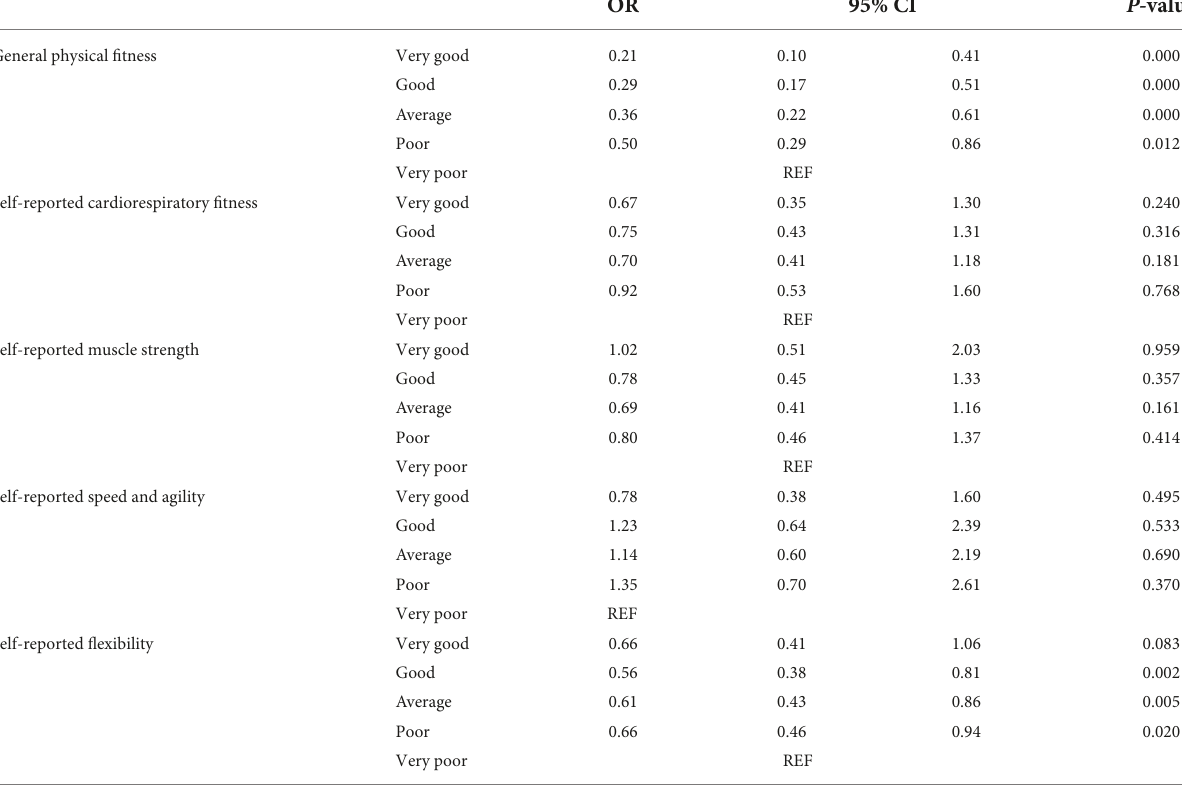
TABLE 6 The association between self-reported physical fitness and depression.